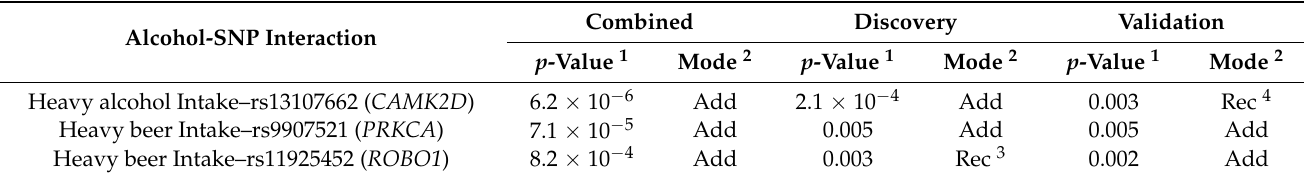
Table 2. Three verified alcohol–single nucleotide polymorphism (SNP) interactions associated with prostate cancer aggres- siveness.